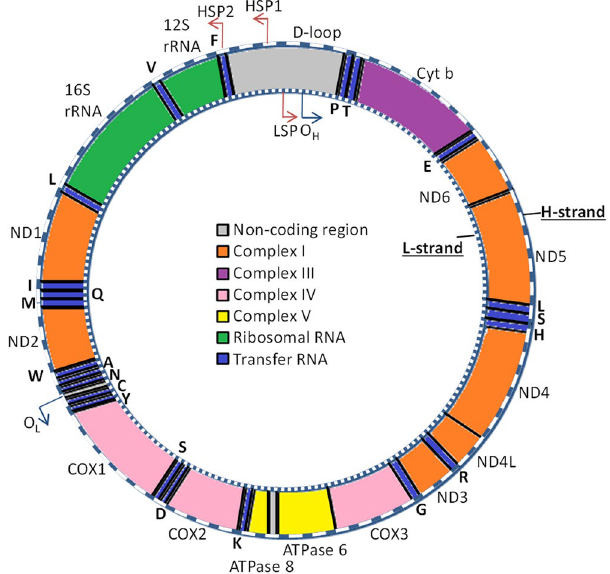
Figure 1. Mitochondrial DNA (mtDNA). The human mtDNA is a 16,569 bp circular DNA, containing a heavy (H, outer ring) and light (L, inner ring) strand. The genes encoded from the L-strand are written inside the circular DNA, whereas genes encoded from the H-strand are written on the outside. The protein-coding genes encode for the complexes required for oxidative phosphorylation (Complex I: orange, complex III: purple, complex IV: pink, complex V: yellow). The D-loop region contains the promoters for the L- and H-strand (LSP, HSP1, HSP2) and the origin of replication of the H-strand (O H